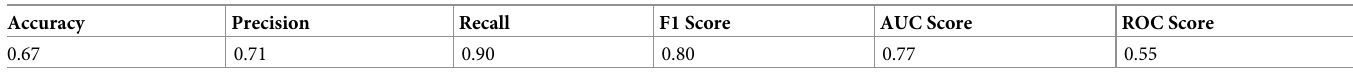
Table 2. Summary table of accuracy, precision, recall, f1-score, and AUC, and ROC Score from the random forest